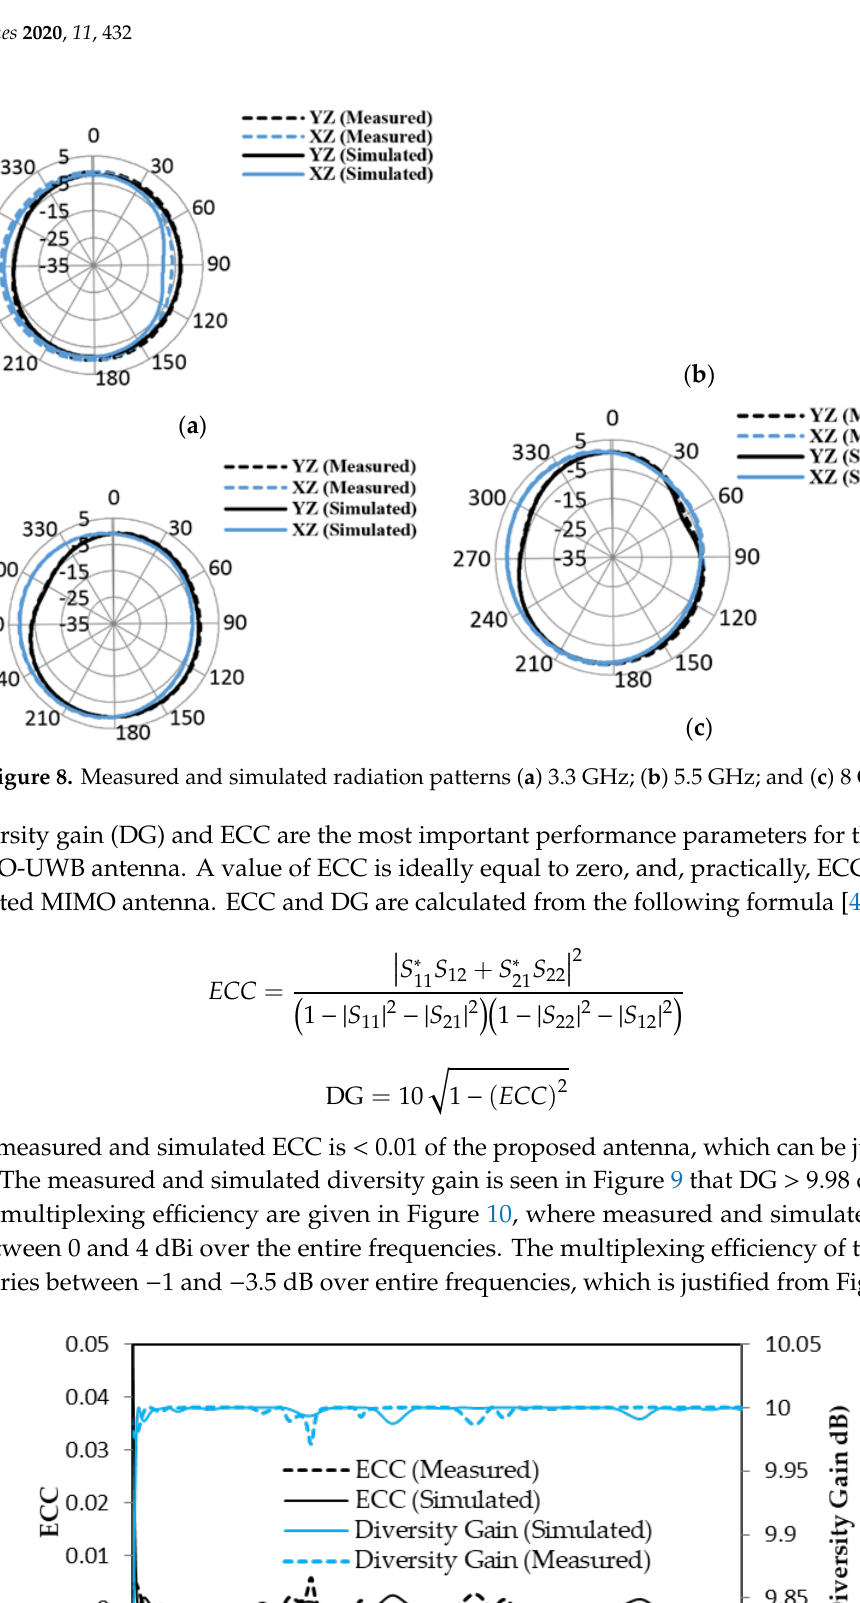
parameters of proposed MIMO antenna.